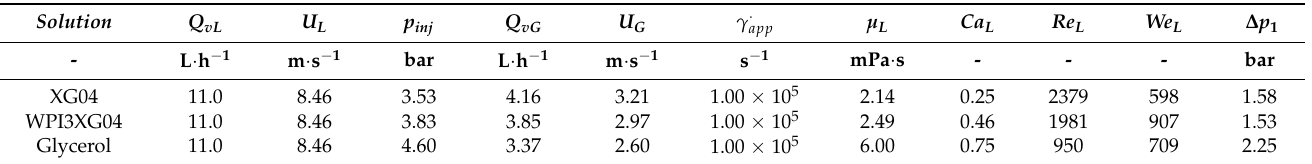
Figure 11. Effect of formulation on two-phase flow typology and bubbles sizes. ( a ) High-speed visualizations of the two- phase flow inside the mixing channel of the device CX600 for solutions WPI3XG04, XG04 and glycerol at Q vL = 11 L.h −1 and Q mG = 21.6 g.h −1 . ( b ) Bubble size distribution in cumulative volume for bubbles inside the mixing channel of CX600 for solutions WPI3XG04, XG04 and glycerol at Q vL = 11 L.h −1 and Q mG = 21.6 g.h −1 . The diameters of bubbles inside the micro- channels are normalized to the atmospheric pressure. ( c ) High-speed visualizations of the two-phase flow inside the ex- pansion channel of the device CX-E-600 for solutions WPI3XG04, XG04 and glycerol at Q vL = 3 L.h −1 and Q mG = 5 g.h −1 . Table 4. Hydrodynamic parameters of the two-phase flow in the mixing channel of the microfluidic device CX600 for the XG04, WPI3XG04 and glycerol solutions at Q vL = 11 L.h −1 -Q mG = 21.6 g.h −1 . Solution